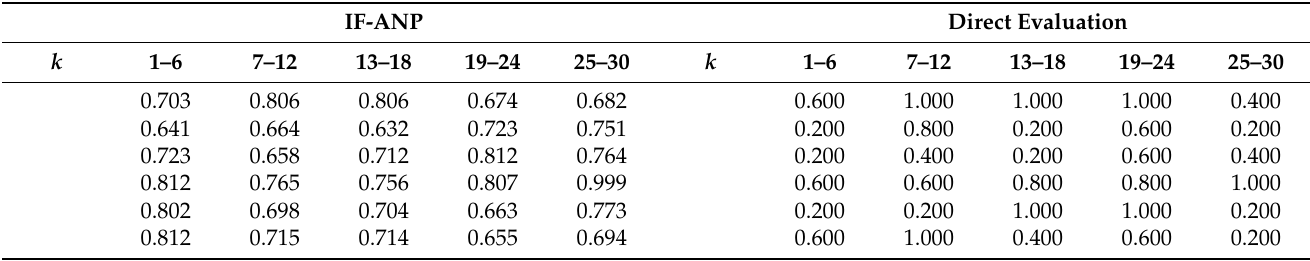
Table 11. Normalized I (k) ( D → C ) values given by the IF-ANP and by direct evaluation. IF-ANP Direct